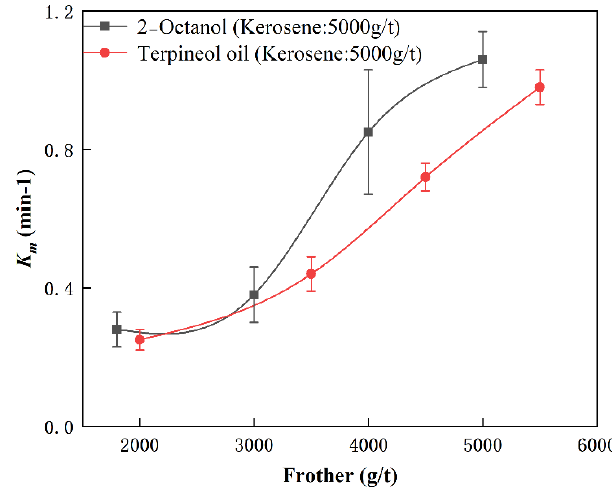
Figure 6. K m value under different dosages of frother.